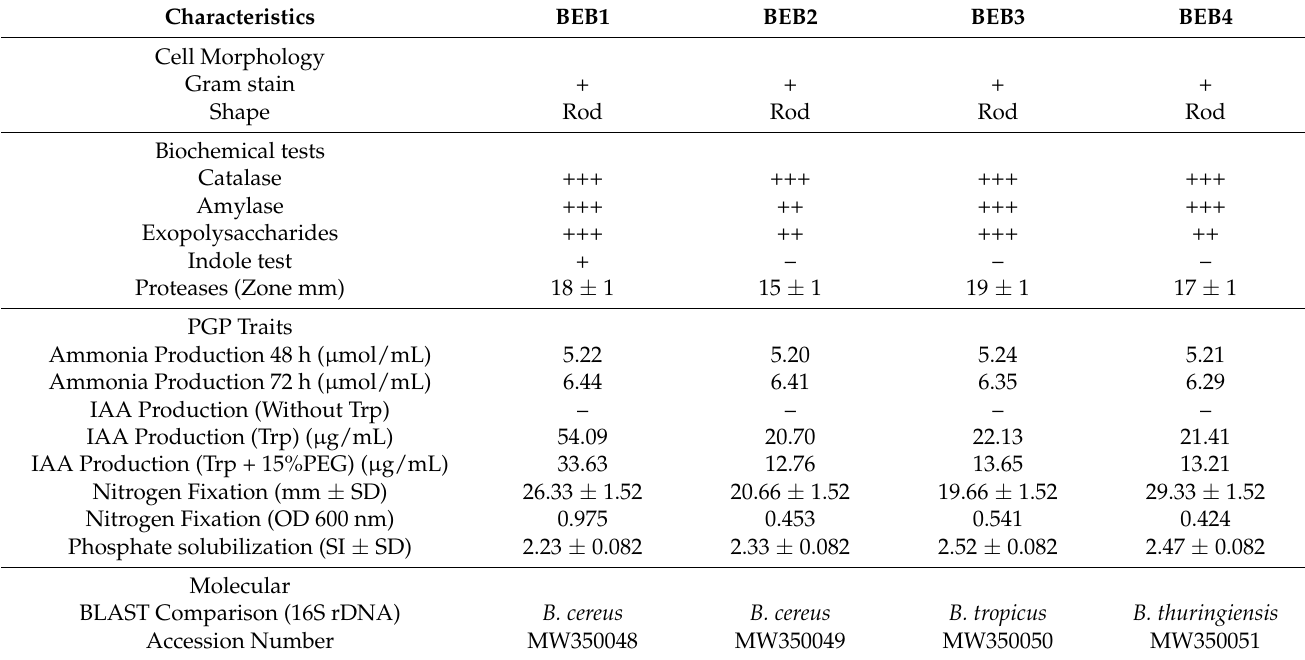
Table 2. Characterization of bacterial strain for enzyme production and in vitro PGP